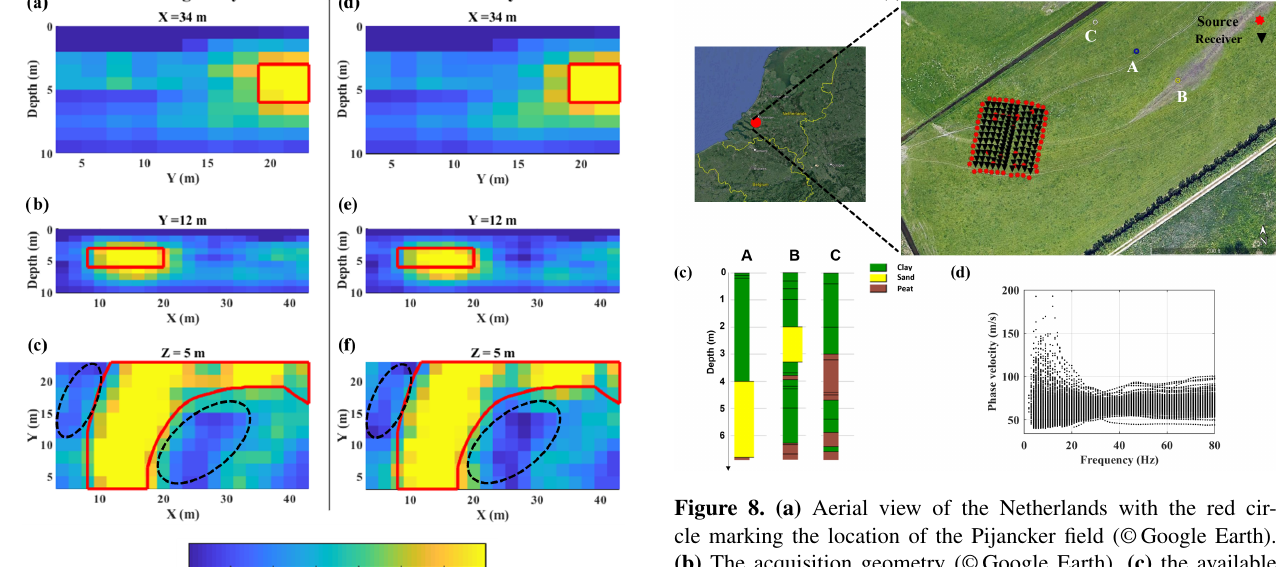
inversion results for one horizontal and two vertical slices of the model are shown in Fig. 7.